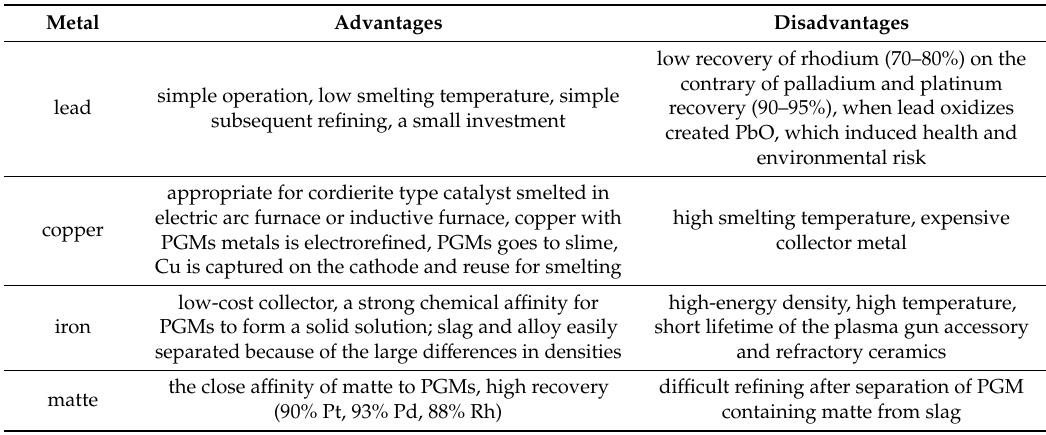
Table 3. Advantages and disadvantages of metals